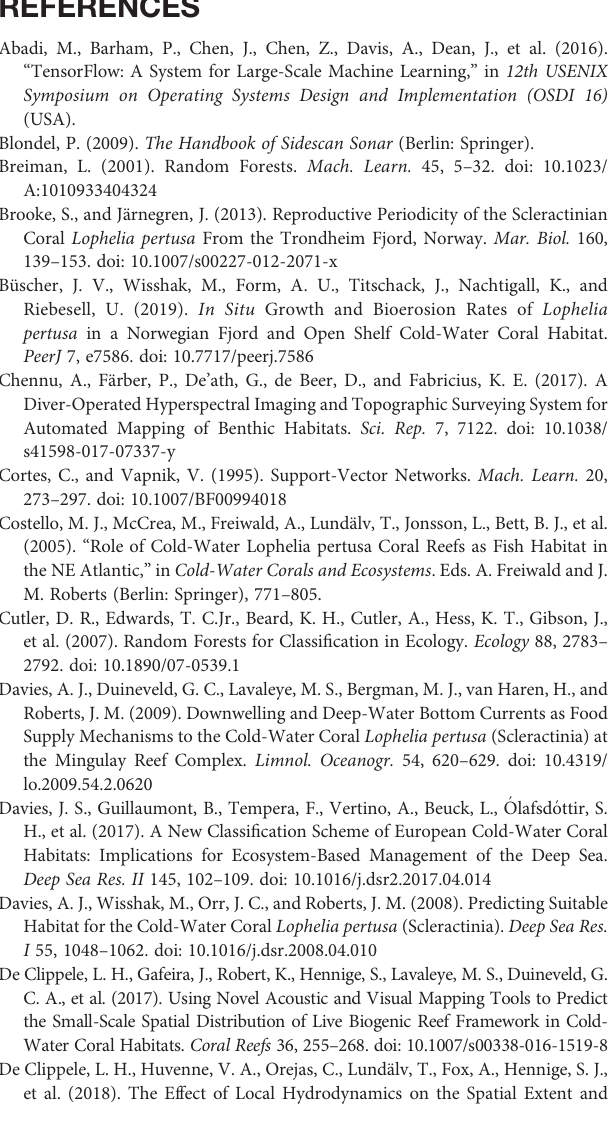
Supplementary Figure 1 | The georeferenced underwater hyperspectral imaging (UHI)mosaicfromtheTautraRidgevisualizedinred(R;590nm),green(G;530nm)and blue (B; 460 nm). The map was created in ArcMap (v. 10.8; Esri Inc., Redlands, USA; https://desktop.arcgis.com/en/arcmap/). Projection: UTM 32N. Datum: WGS 1984. Supplementary Figure 2 | The training data used for support-vector machine (SVM) classi fi cation of underwater hyperspectral imagery from the Tautra Ridge.